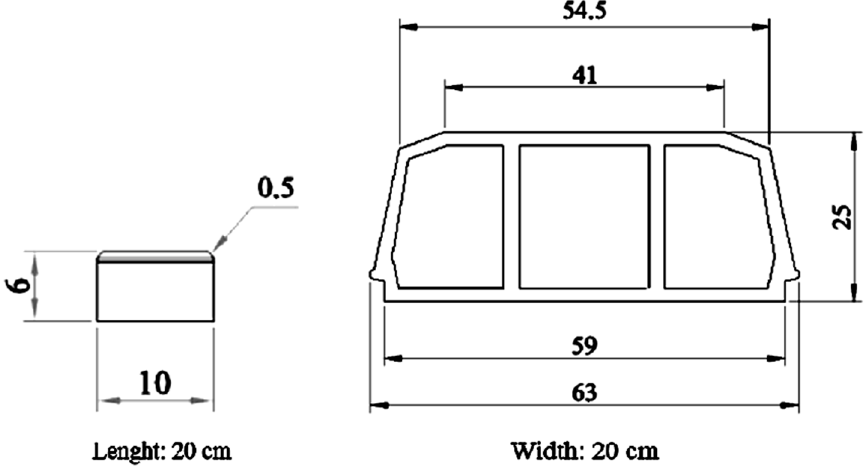
Figure 2. Geometrical dimensions (in cm) of pavement blocks ( left ) and hollow tiles ( right ) used in this study.